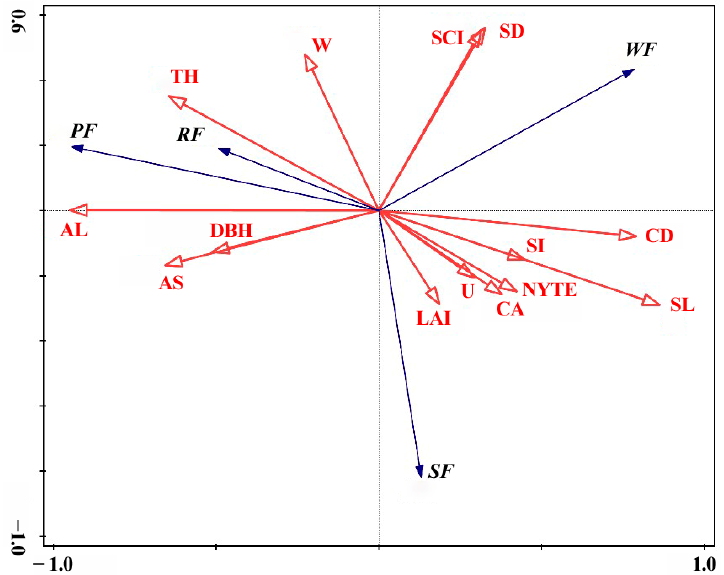
Figure 3. The redundancy analysis ordination diagram of the SSTFs and EFFIs. In the sequence